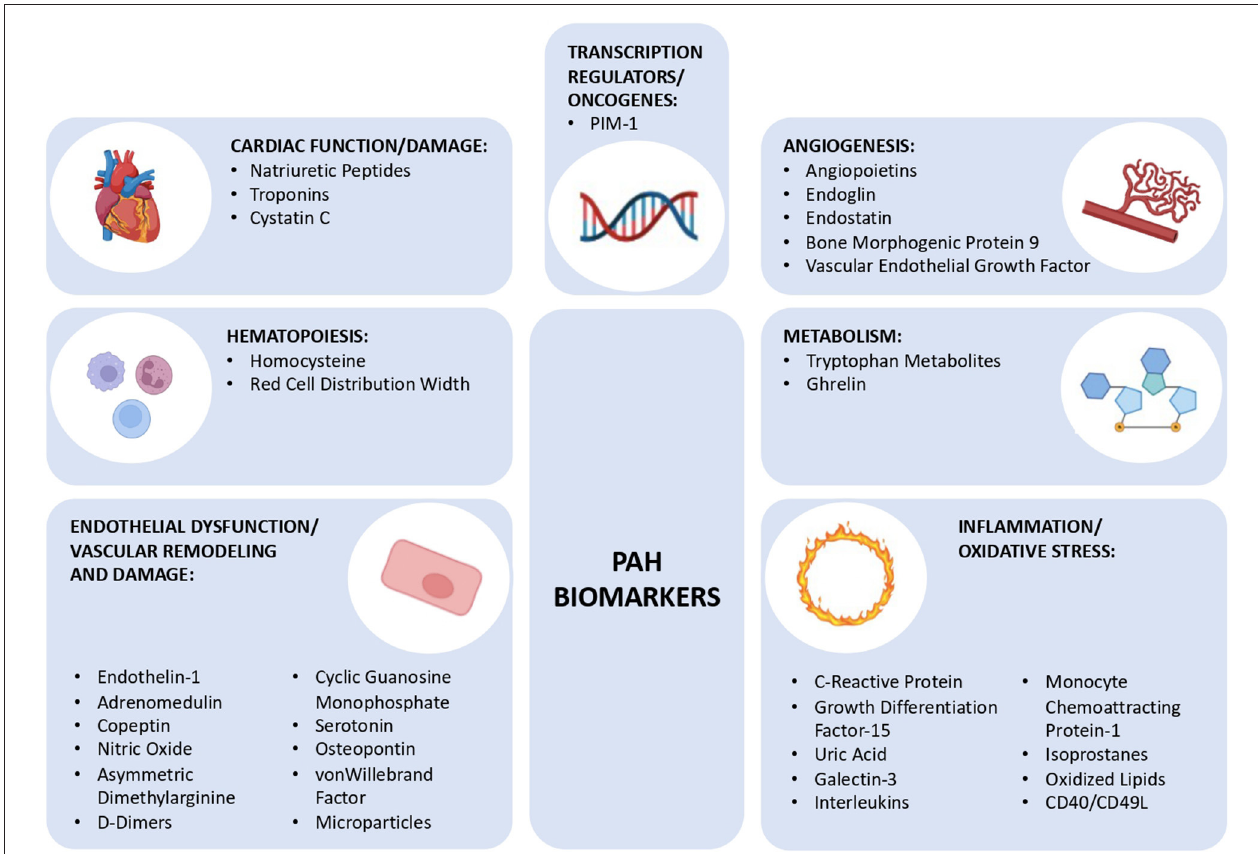
FIGURE 1 | Schematic diagram showing the different group of biomarkers for pulmonary arterial hypertension discussed in this review, subclassified into 7 groups: cardiac function/damage, hematopoiesis, endothelial dysfunction/vascular remodeling and damage, angiogenesis, metabolism, inflammation/oxidative stress, and transcription regulators/oncogenes. PIM-1, Moloney Murine Leukemia Provirus Integration